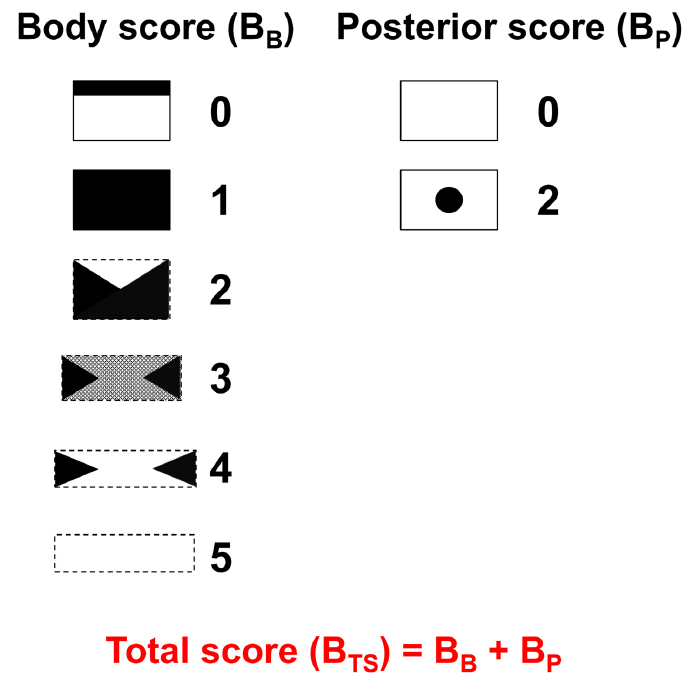
Figure 1. Schematic representation of the new bone scan scoring system which consists of the body score (B B ) and posterior score (B P ). B B was classified as follows: 0, linear uptake in the upper